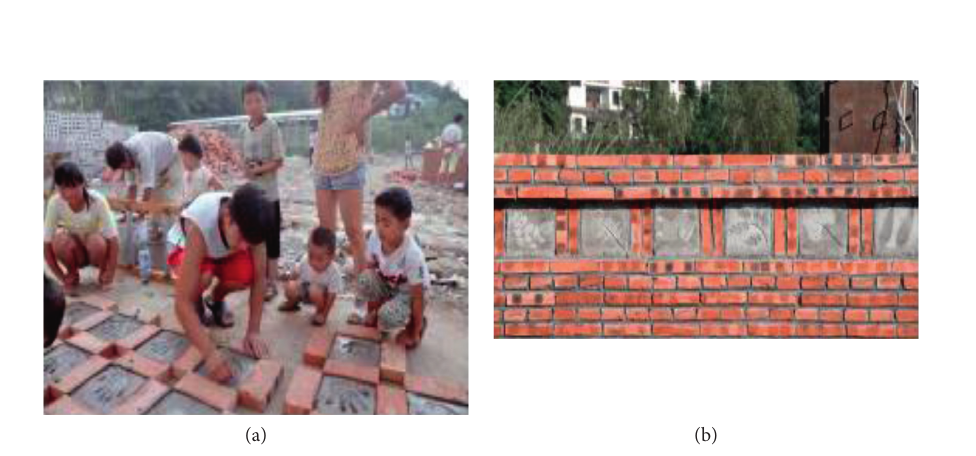
Figure 7: Cultural logo landscape wall (the picture comes from